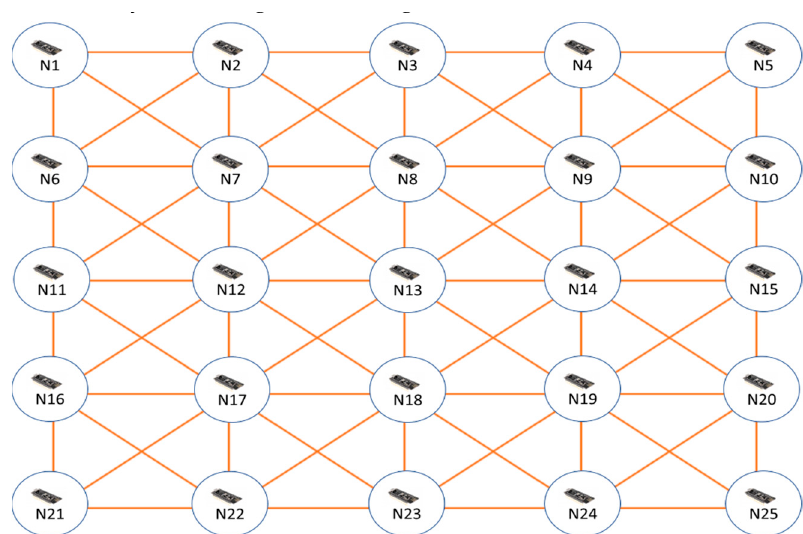
Figure 3. Sensor node in 4-way grid topology.